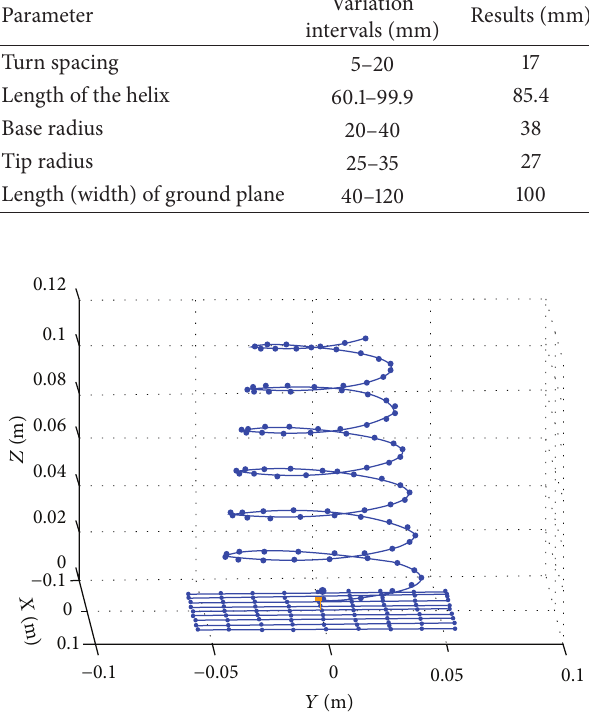
Figure5:Implementationofthehelicalantennaabovefiniteground plane with SuperNEC.